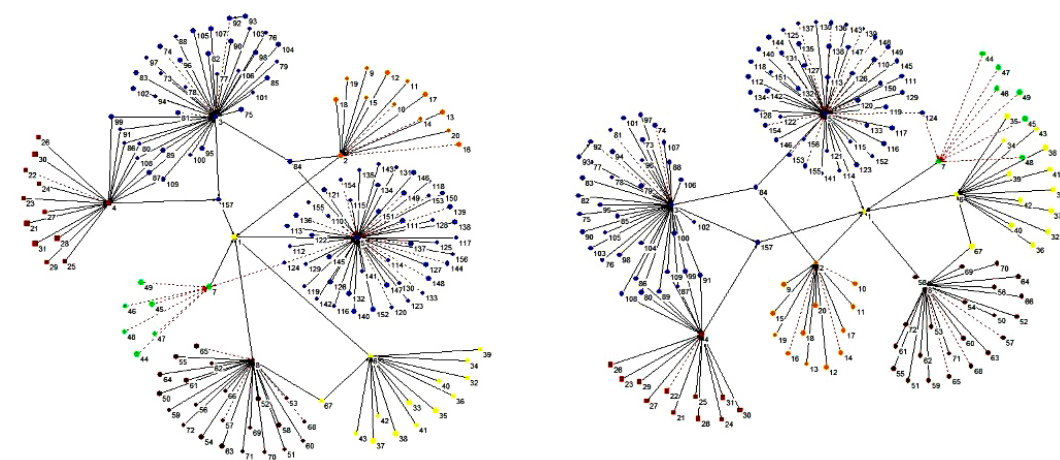
Fig. 3. Different perspectives of the agreed collective map